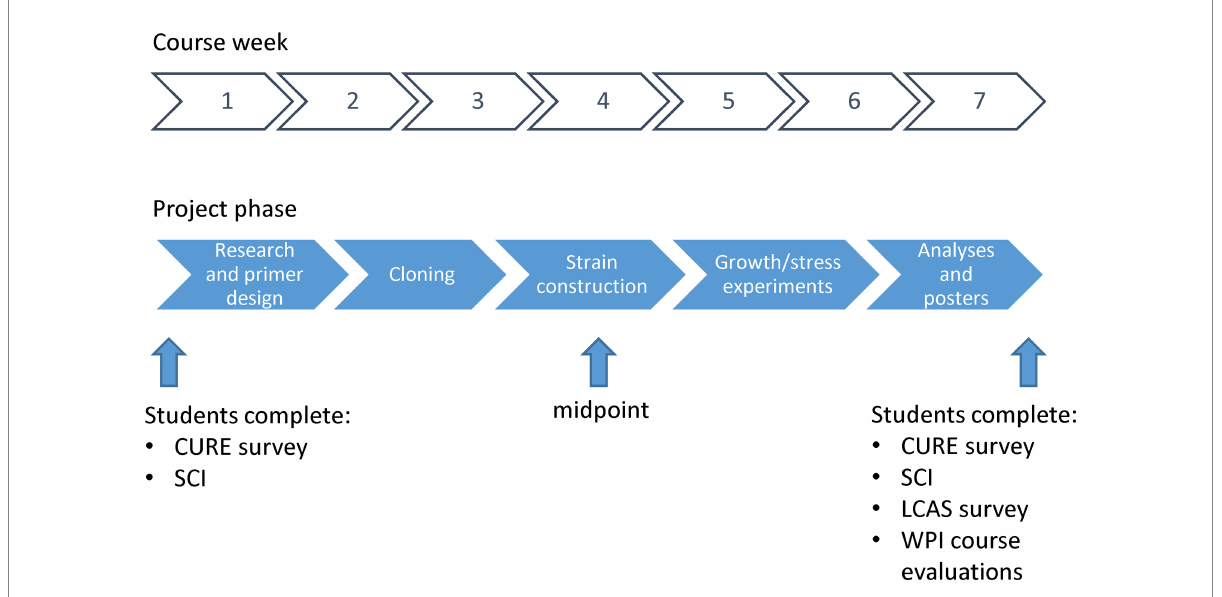
FIGURE 2 General timeline of student experiments and course